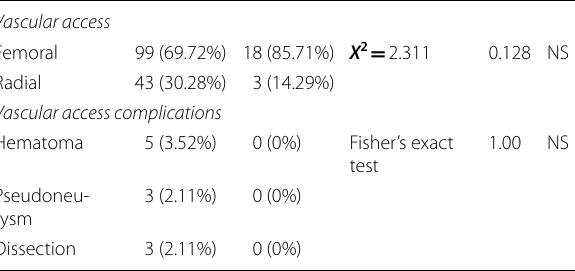
*Chi-square test of significance ( X 2 )